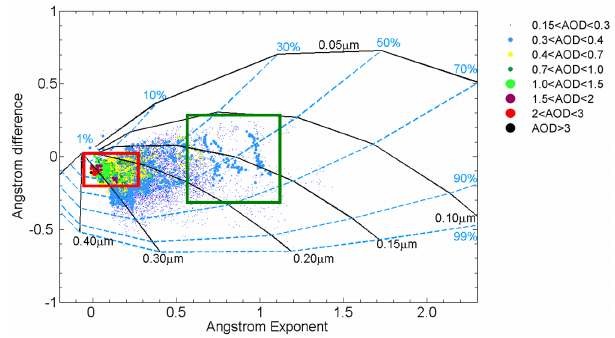
Figure 6. Ångström exponent difference, δ AE = AE ( 440 , 675 ) − AE ( 675 , 870 ) , as a function of AE and AOD (refer to legend for colour and symbol description) at the Tamanrasset site (10460 ob- servations) (reprinted from Guirado et al., 2011). Strong dust events (red rectangle) and a mixture of different aerosol types (green rect- angle) are indicated. δ AE, AOD and AE are dimensionless parame-